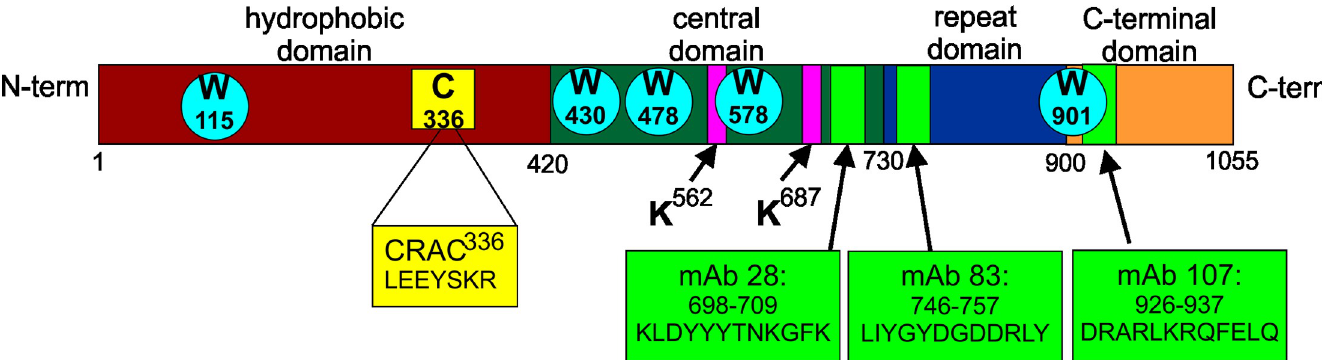
Fig 1. Four functional domains of LtxA. The hydrophobic domain (residues 1–420, red) contains most of the hydrophobic amino acid residues of LtxA. The central domain (residues 421–730, green) contains two internal lysine residues (K 562 and K 687 , bars, K) that are the sites of post-translational acylation. The repeat domain (residues 731–900, blue) contains the characteristic repeated amino acid sequence of the RTX family. The C-terminal domain (residues 901–1055, orange) is hypothesized to play a role in secretion. A cholesterol binding site (CRAC 336 , yellow square, C) is located in the hydrophobic domain. Five tryptophan residues (blue circles, W) are located throughout the sequence of LtxA at residues 115, 430, 478, 577, and 901. The three monoclonal antibody epitopes are marked with green bars; mAb 28 recognizes residues 698–709, mAb 83 recognizes residues 746–757, and mAb 107 recognizes residues 926–937